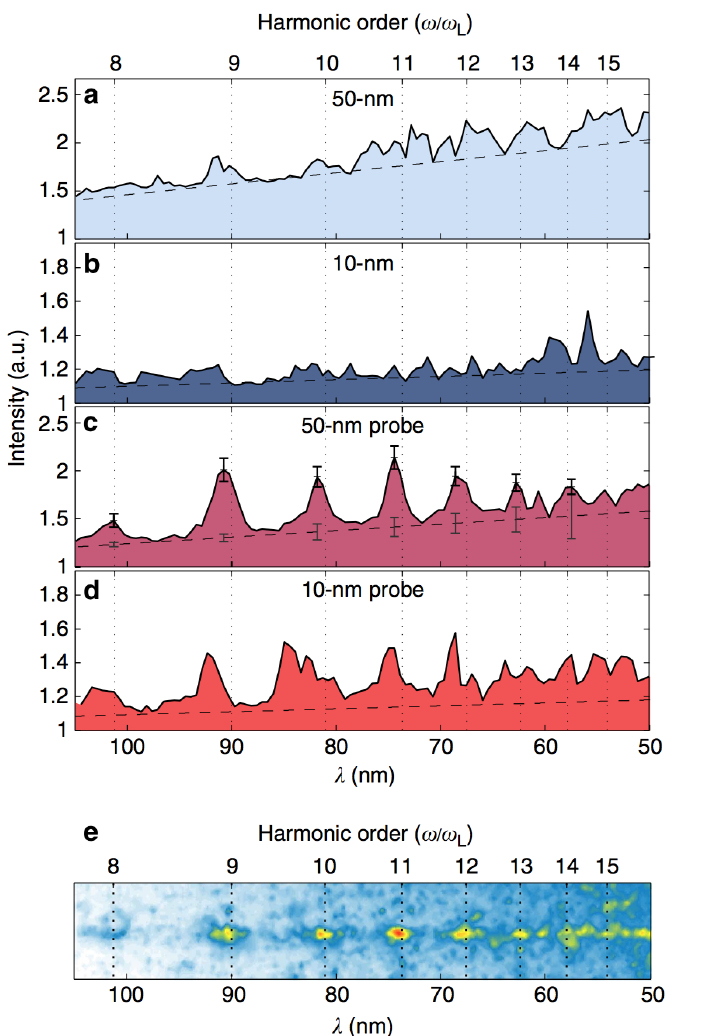
Figure 2. Experimentally observed spectra reproduced from [31]. ( a , b ) are spectra from the shots without counter-propagating pulses while ( c , d ) are spectra with them. ( e ) Detector image obtained from a 50-nm probe